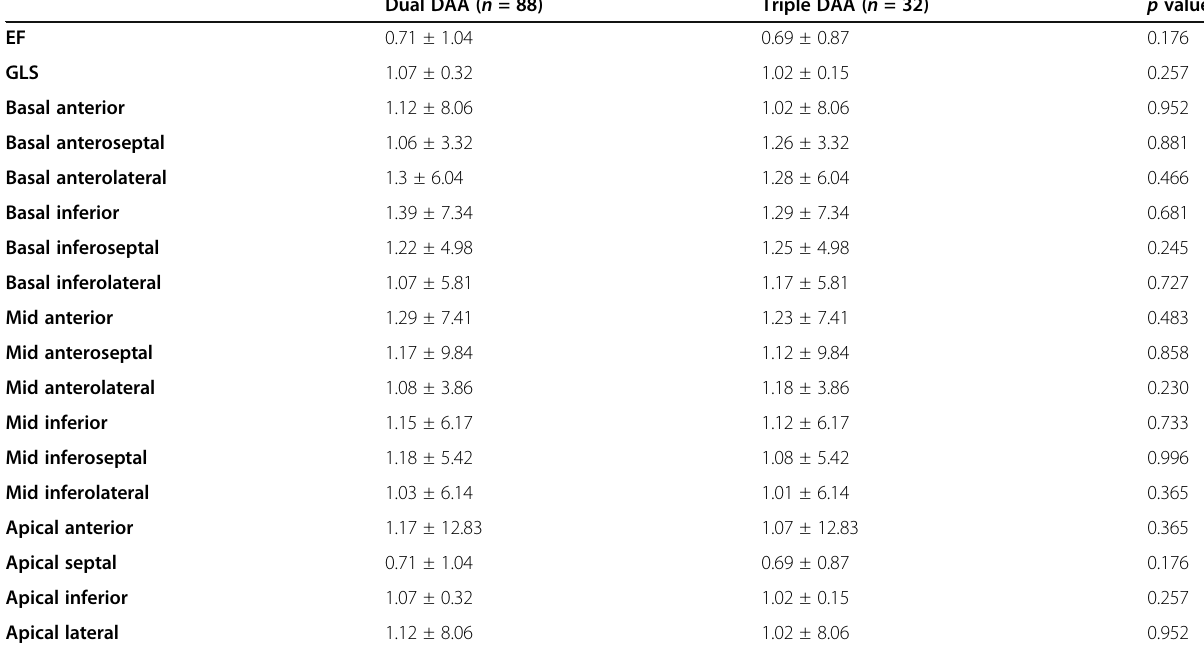
Table 4 Absolute changes in GLS, segmental strain and estimated LVEF% after receiving antiviral treatment in dual and triple DAA regimen